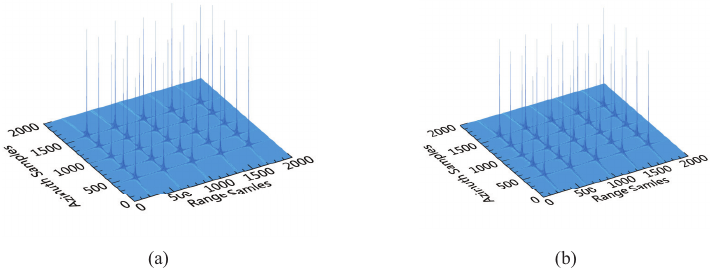
Figure 13. Focusing result of point targets. The result is processed with ( a ) BiBulk_FFBP and ( b ) FBP in [25].